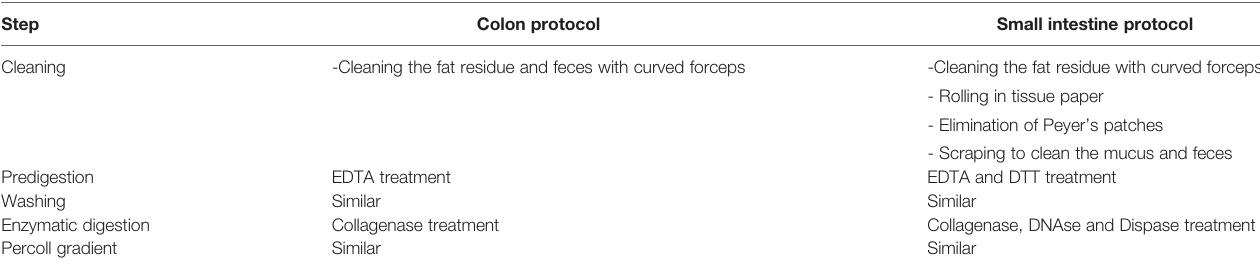
TABLE 1 | Differences in the steps of the protocols for colon and small intestine.